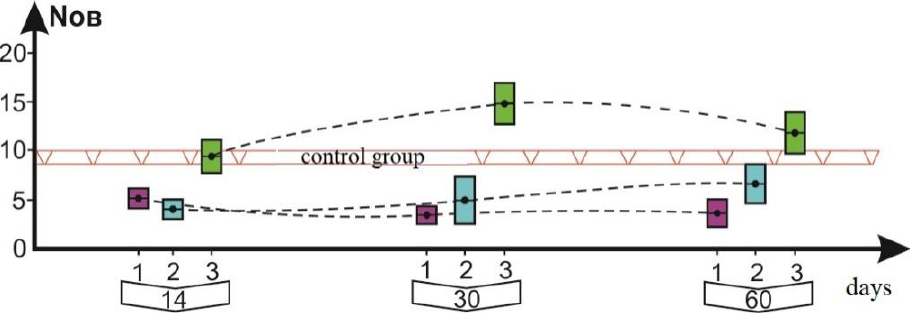
Figure 6. Changes to parameter N.Ob. The designations and colors on the graph correspond to those shown in Figure 4.